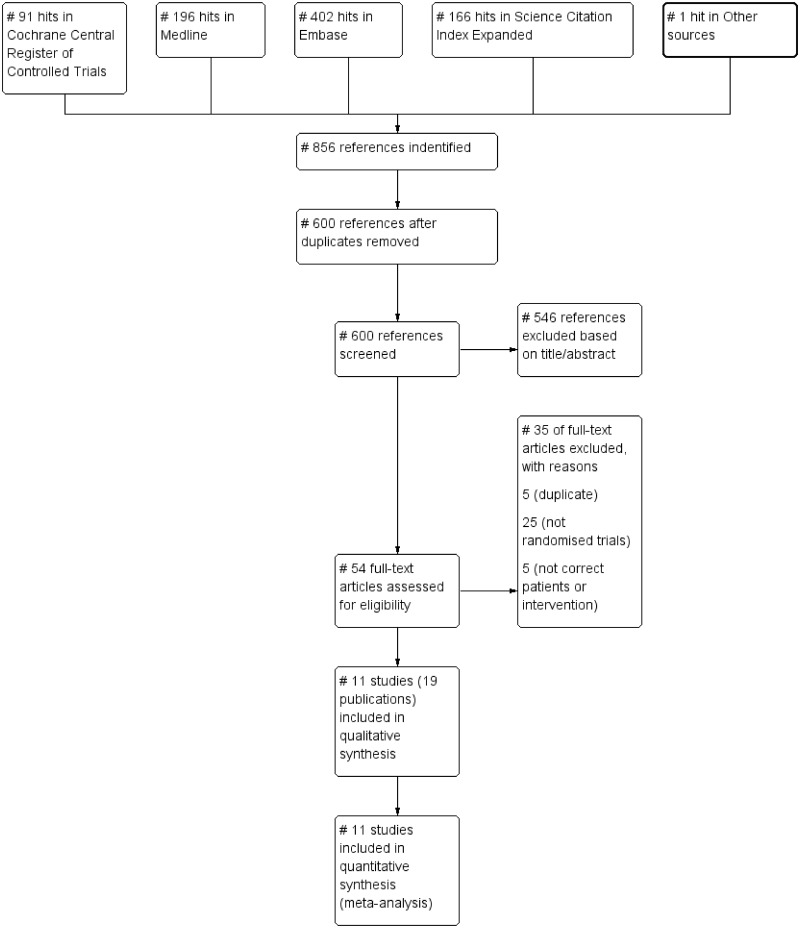
PRISMA flow diagram illustrating the selection procedure.